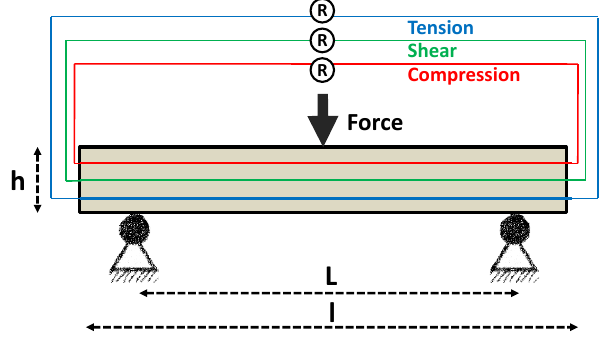
Figure 5. Test device, specimen and sensor layout (according to locus of maximum compression, maximum shear and maximum flexural stresses) for the three-point bending test on a rectangular unidirectional GF/PP composite with the direction of fibers along the specimen’s length axis [15].